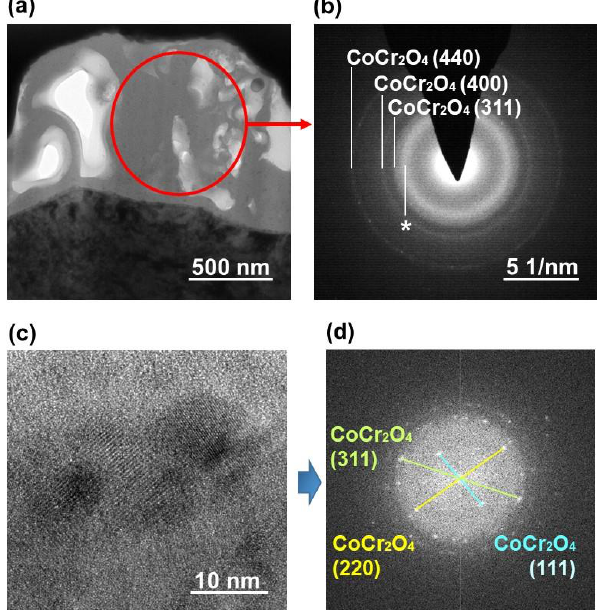
Figure 8. ( a ) Bright-field TEM image of the ultra-thin cross-section of the CaP layer formed on the LAB-processed (30 min) Co−Cr alloy substrate; ( b ) selected area electron diffraction (SAED) pattern obtained from the circled area in ( a ); ( c ) high-resolution TEM (HRTEM) image obtained from the nanoparticles dispersed in ( a ); and ( d ) fast Fourier transform (FFT) pattern of ( c ).